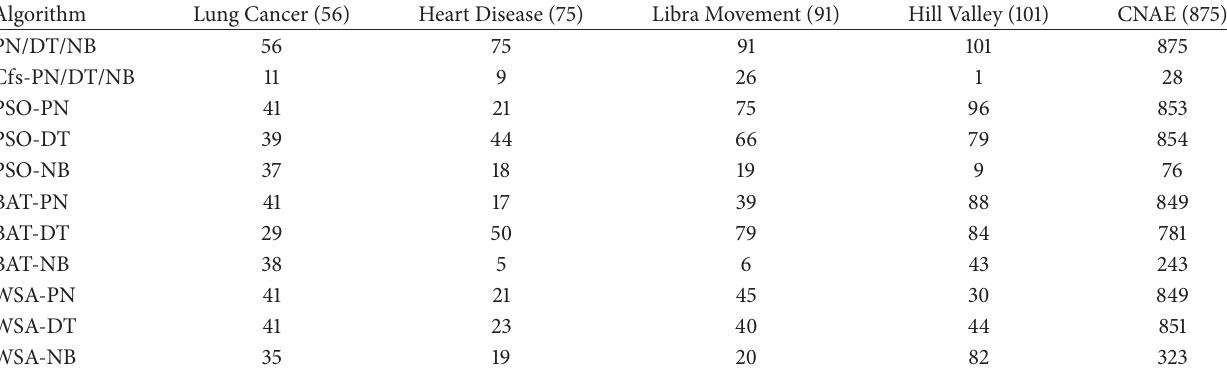
Table 7: Comparative results in feature amount in feature subgroup for all the classification algorithms with Cfs feature selection and swarm search feature selection and without any feature